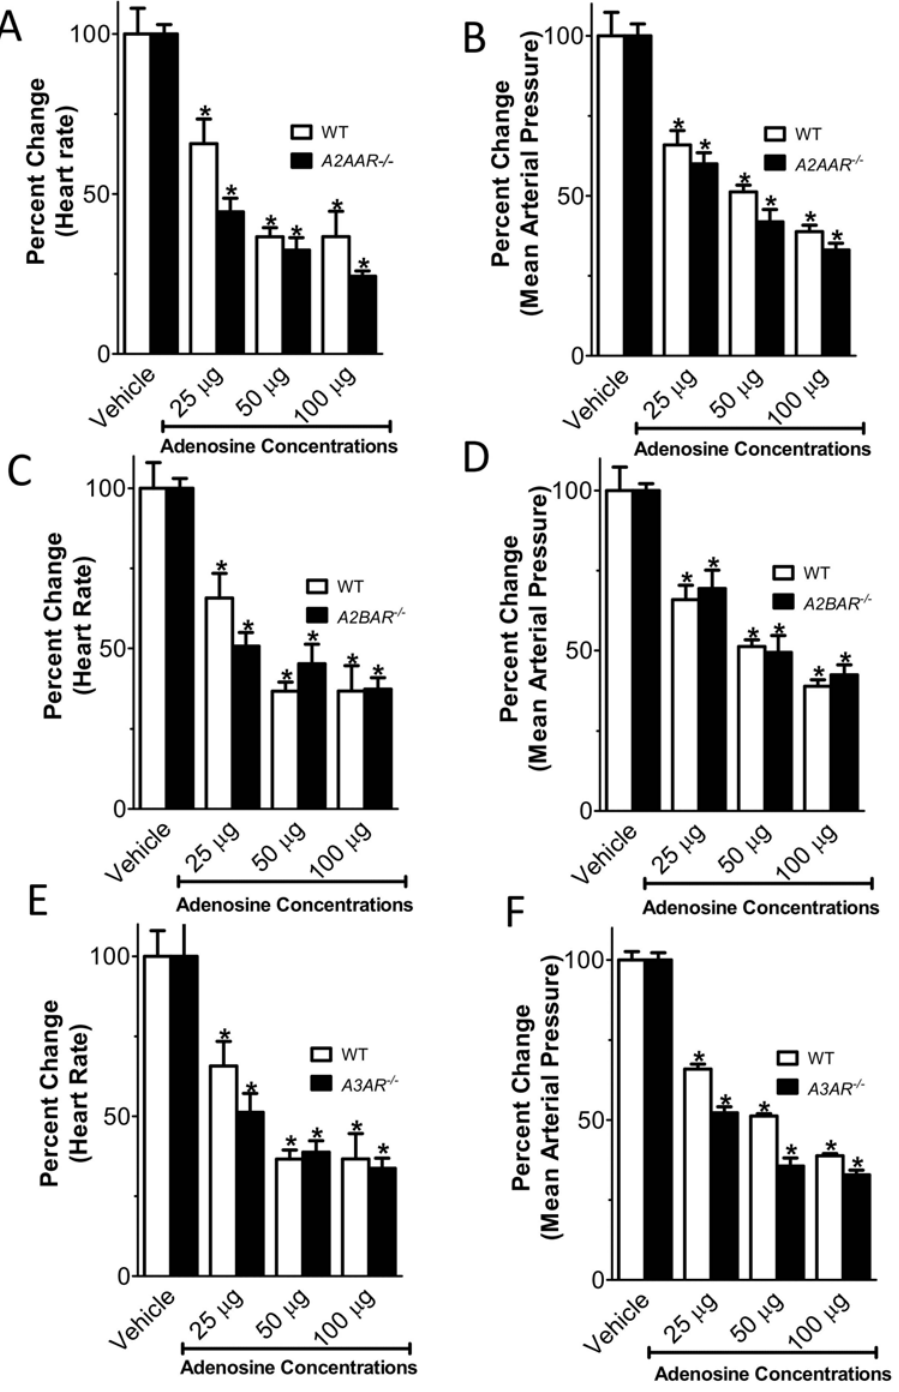
Figure 4. Effect of systemic adenosine administration in AR gene targeted mice. Following insertion of a catheter into the common carotid artery, mean arterial blood pressure and heart rate were measured. A2AAR 2 / 2 , A2BAR 2 / 2 or A3AR 2 / 2 received bolus injections of vehicle solution or indicated doses of adenosine in 100 m l of vehicle. Change in heart-rate and mean arterial pressure compared to littermate control mice. (A, B) A2AAR 2 / 2 (C, D) A2BAR 2 / 2 (E, F) A3AR 2 / 2 (n=6–8, *p , 0.05 compared to adenosine-vehicle; mean 6 SEM).